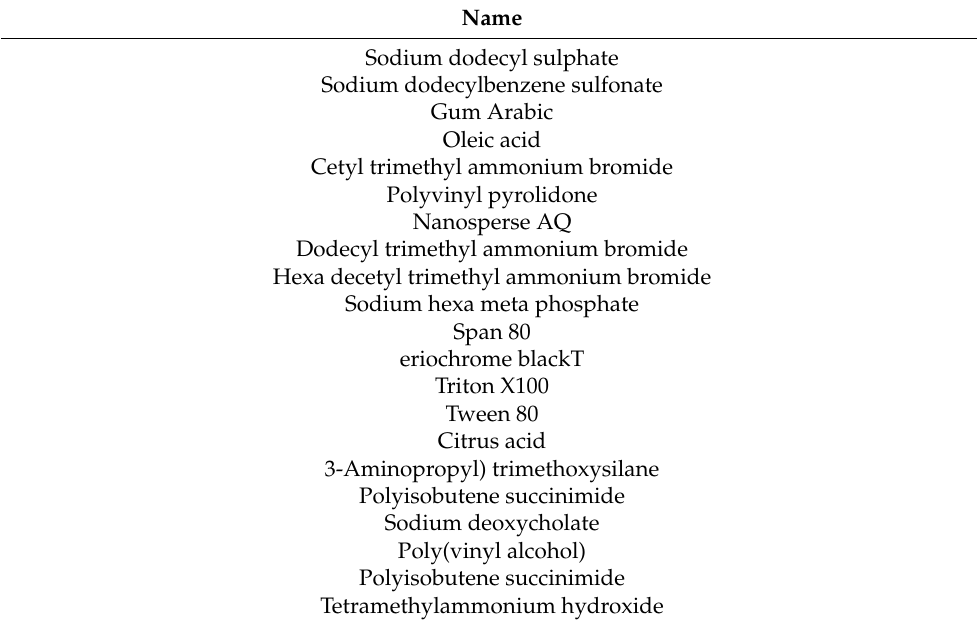
Table 1. List of surfactants used in nanofluid studies.